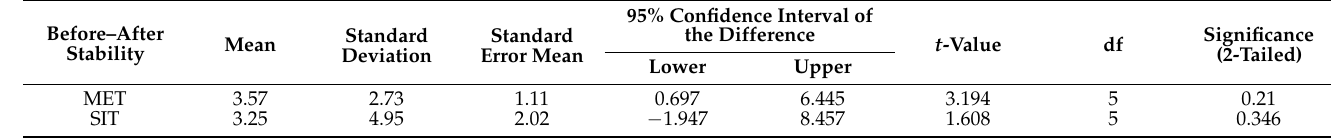
Table 7. Statistical analysis of the optimized formulation (R4) exposed to stability